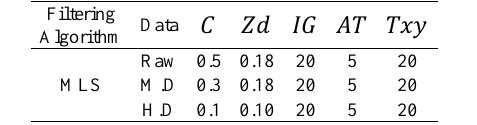
Table 4. The parameters used in the ETEW algorithm (M.D stands for medium-density and H.D means high-density)